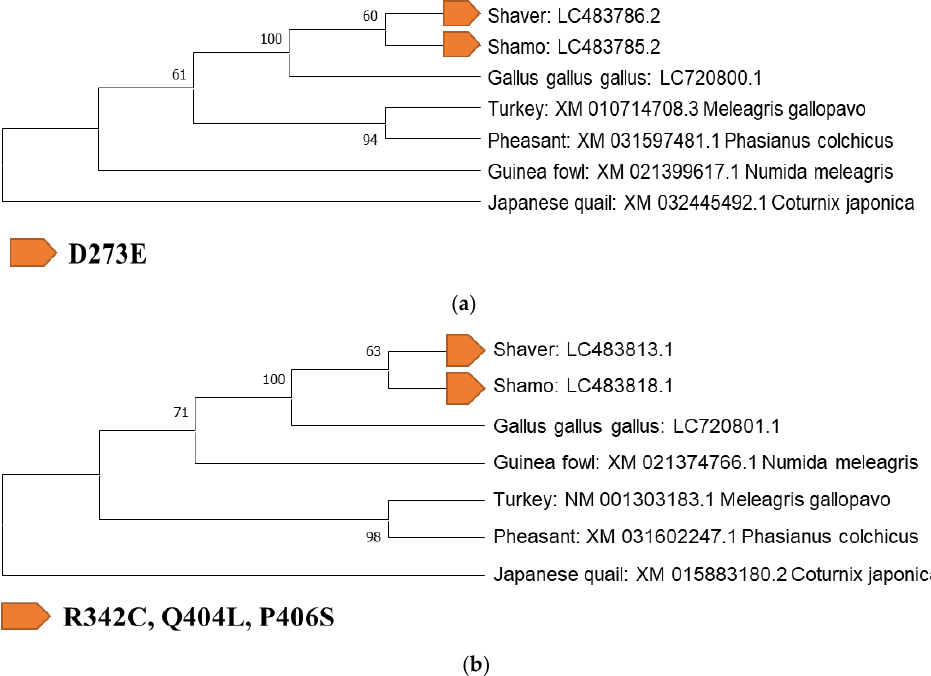
Figure 4. Phylogenetic analysis of the adrenergic receptor (ADR) genes ADRα 2A ( a ) and ADRβ3 ( b ).